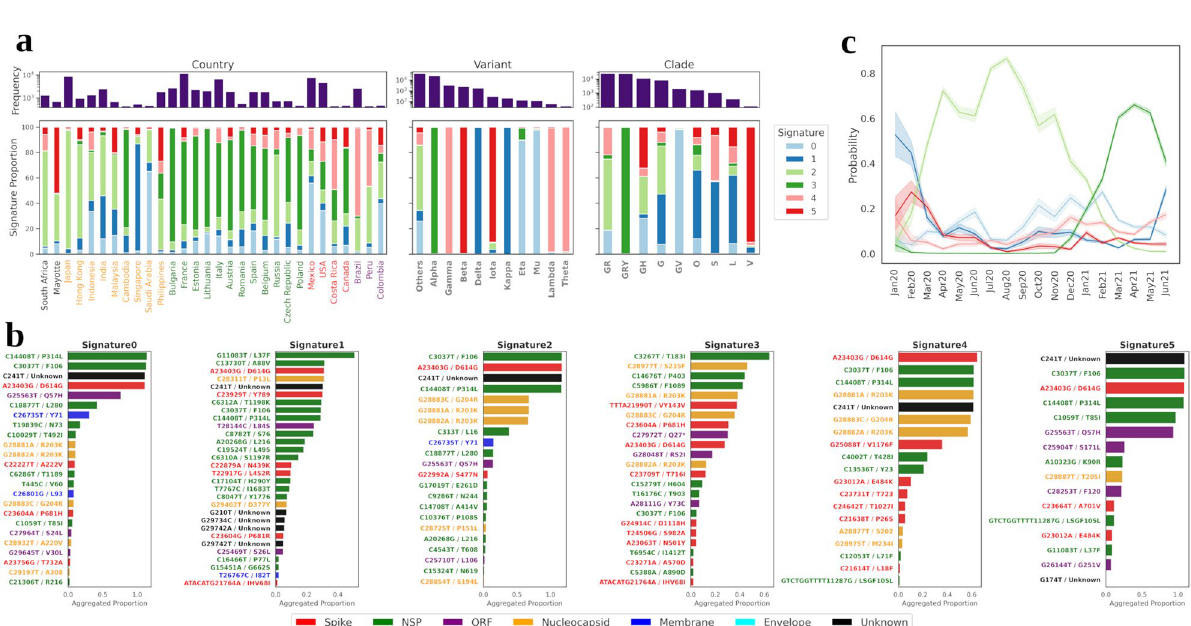
Figure 2. Distribution of mutational signature in SARS-CoV-2 genomes across geography ( a ) Stacked proportions of signatures (topics) in corpus segregated by 3 categories: country, SARS-Cov-2 variant and GISAID clade. The frequency of each constituent within each category are shown at the top of each stacked bar. Within the country subpanel, each country is differentially coloured according to respective continents. ( b ) Aggregated proportions of word probabilities in each signature across all time-slices. Nucleotide mutations coloured in black (as Unknown) are UTRs. ( c ) Temporal probabilities for each